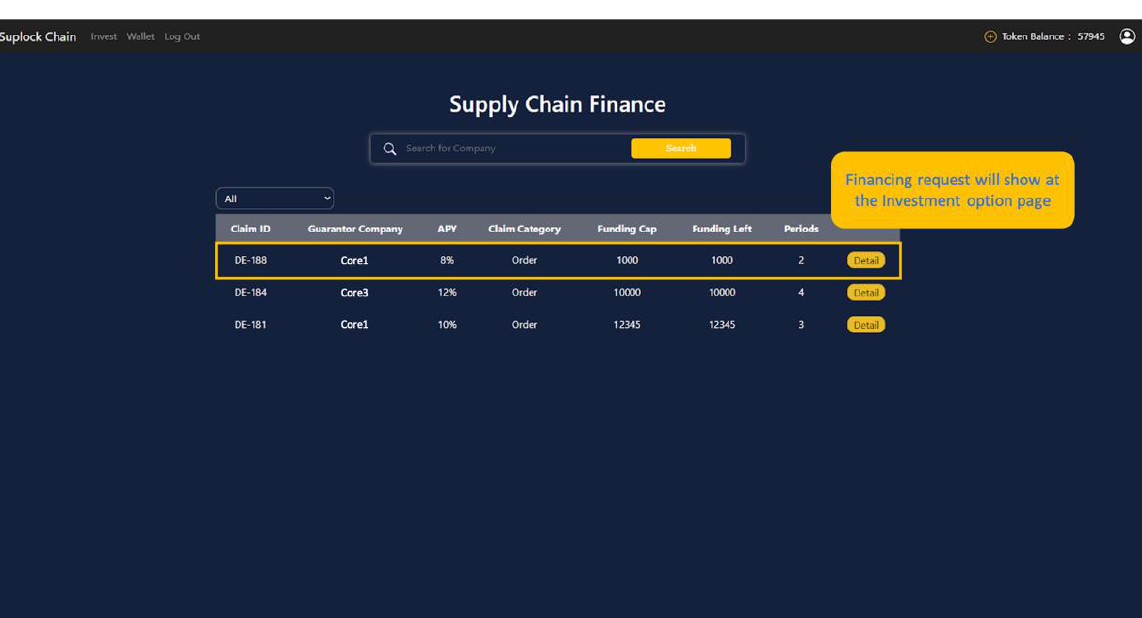
Figure A18. Module for providing fund. Our website lists all the available investments.